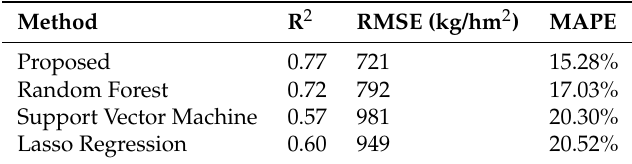
Table 4. Model accuracy using different combinations of data sources.